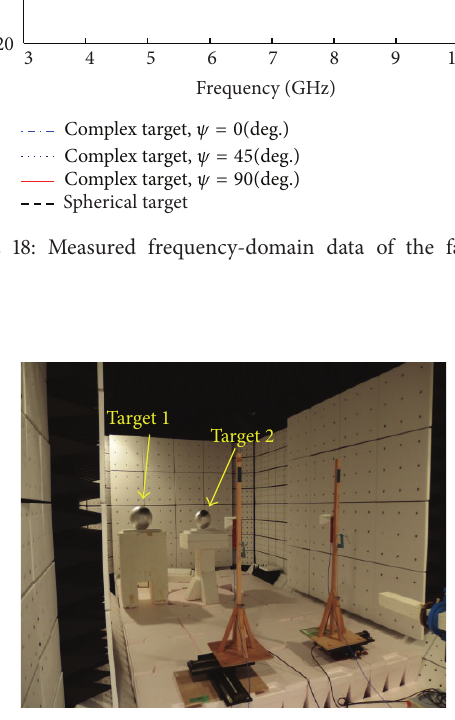
Figure 19: Measurement scenario in a radio anechoic chamber.